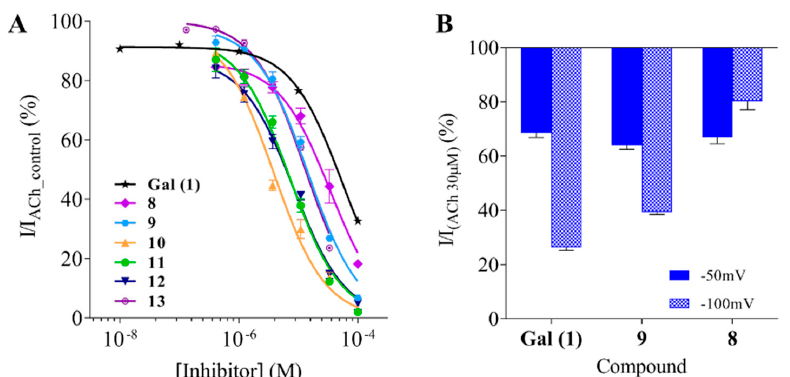
Figure 3. Inhibition of ACh-evoked currents from the human α 7 nAChR expressed in Xenopus oocytes of galantamine and selected VS hits. ( A ) Concentration-response relationships measured by whole-cell, voltage-clamp experiments (holding potential − 60 mV). Inward nicotinic currents were recorded after 25 s incubation with a test or Gal solution followed by 20 s co-application with 30 µ M ACh. Peak current amplitudes were measured and normalized with respect to the amplitude of current elicited by 30 µ M ACh, n = 3. ( B ) Potential-inhibition dependence was determined by conducting experiments at two holding potentials − 50 and − 100 mV. Oocytes were pre-incubated with the test solution (25 s) and the test solution with 30 µ M ACh was co-applied. Gal was tested at 30 µ M, compounds 8 and 9 at 10 µM. Peak current amplitudes were normalized with respect to the amplitude of current elicited by 30 µM ACh, n = 3–4 cells.